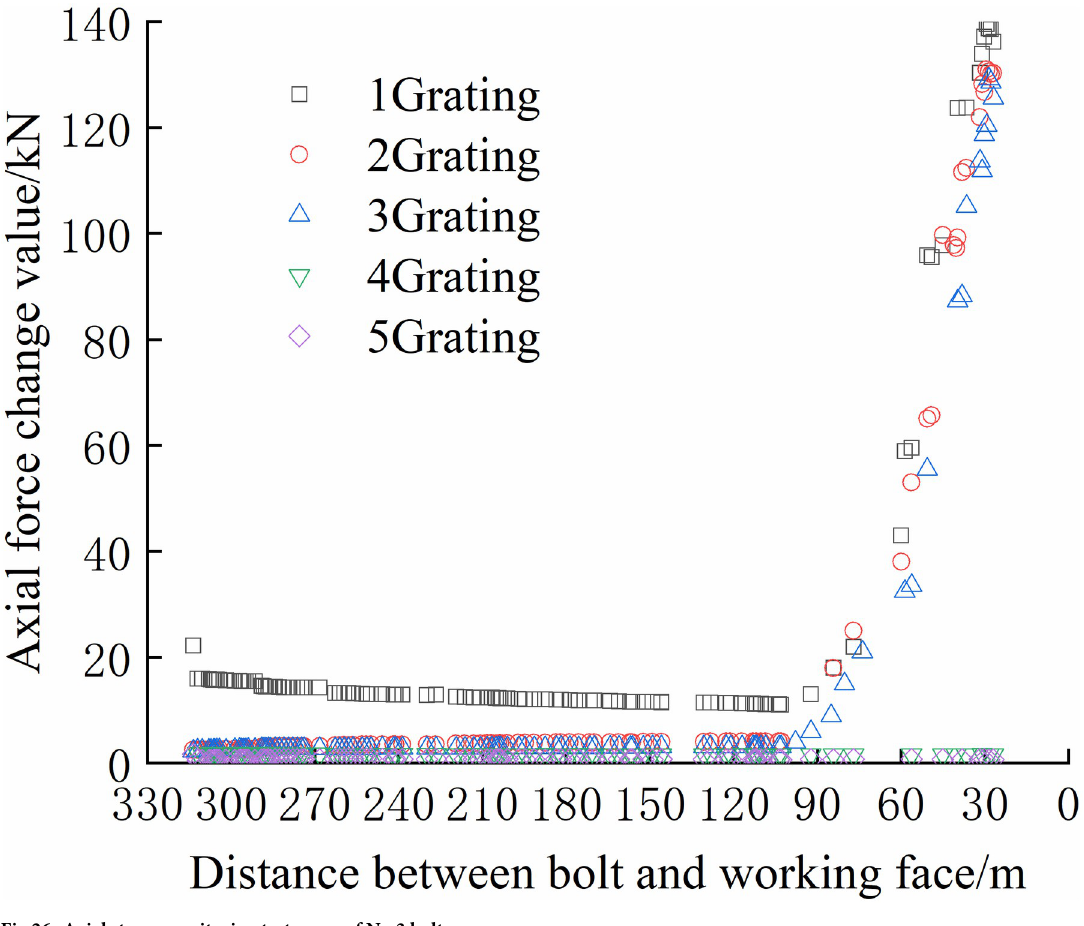
Fig 26. Axial stress monitoring test curve of No.3 bolt.